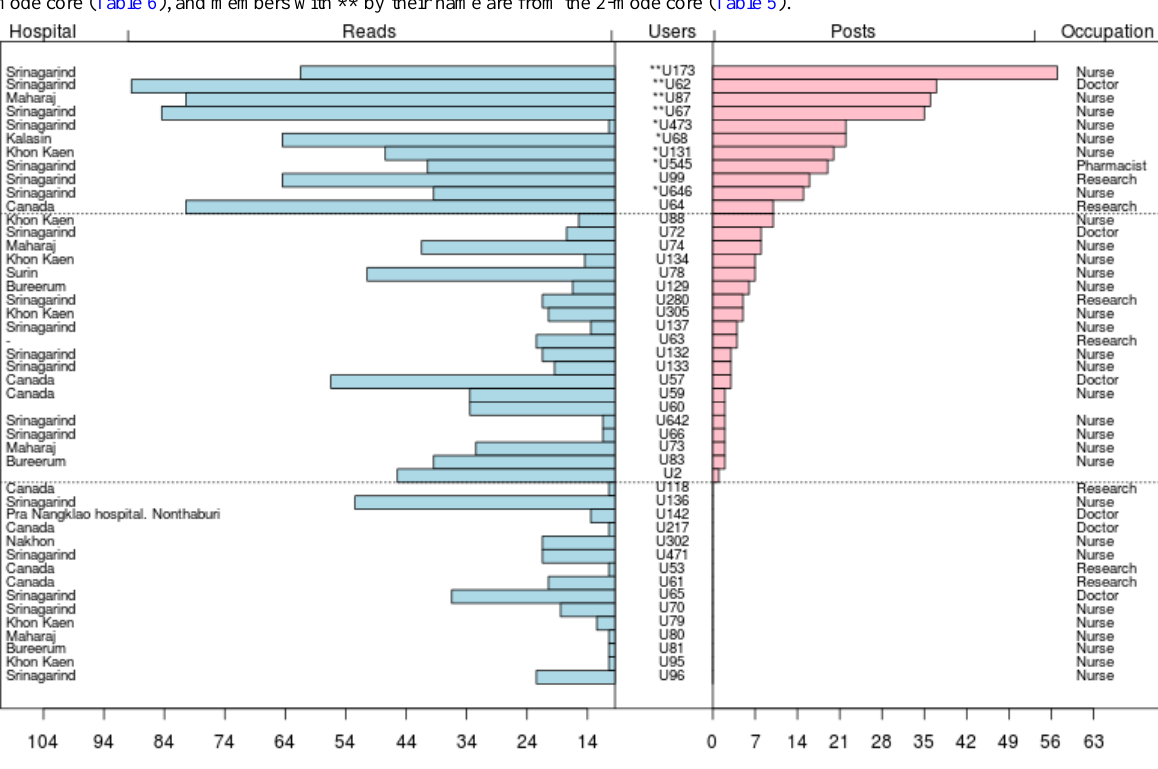
Figure 5. Comparing reads and posts for individual members (note that the partitioning of the figure into 3 sections is done arbitrarily). For this figure, posting is not counted as reading, so the reads represent a member reading a thread and not commenting on it. Members with * by their name are from the 1-mode core (Table 6), and members with ** by their name are from the 2-mode core (Table